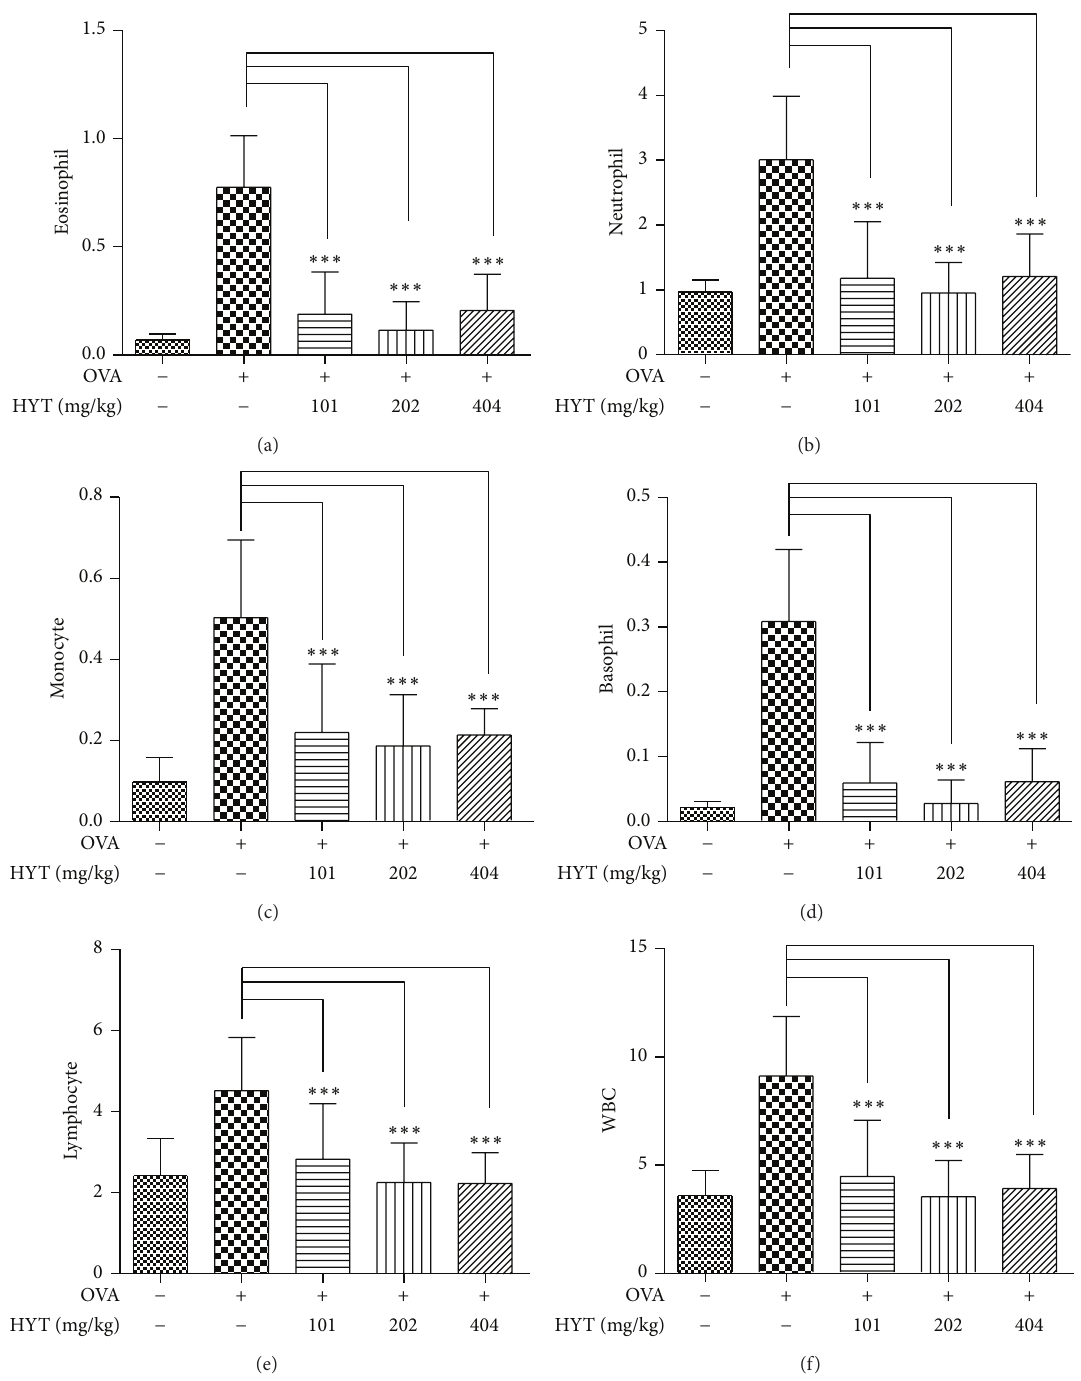
Figure 7: HYT reduced the levels of leukocytes in the blood. Blood samples were analyzed using HEMAVET 950 hematology analyzer. Data are presented as mean ± SEM. ∗ 𝑃 < 0.05 , ∗∗ 𝑃 < 0.01 , and ∗∗∗ 𝑃 < 0.001